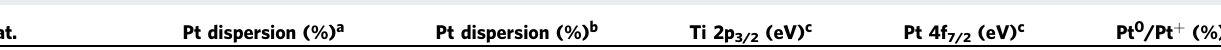
Table 2 Chemisorption and XPS results of Pt catalysts.